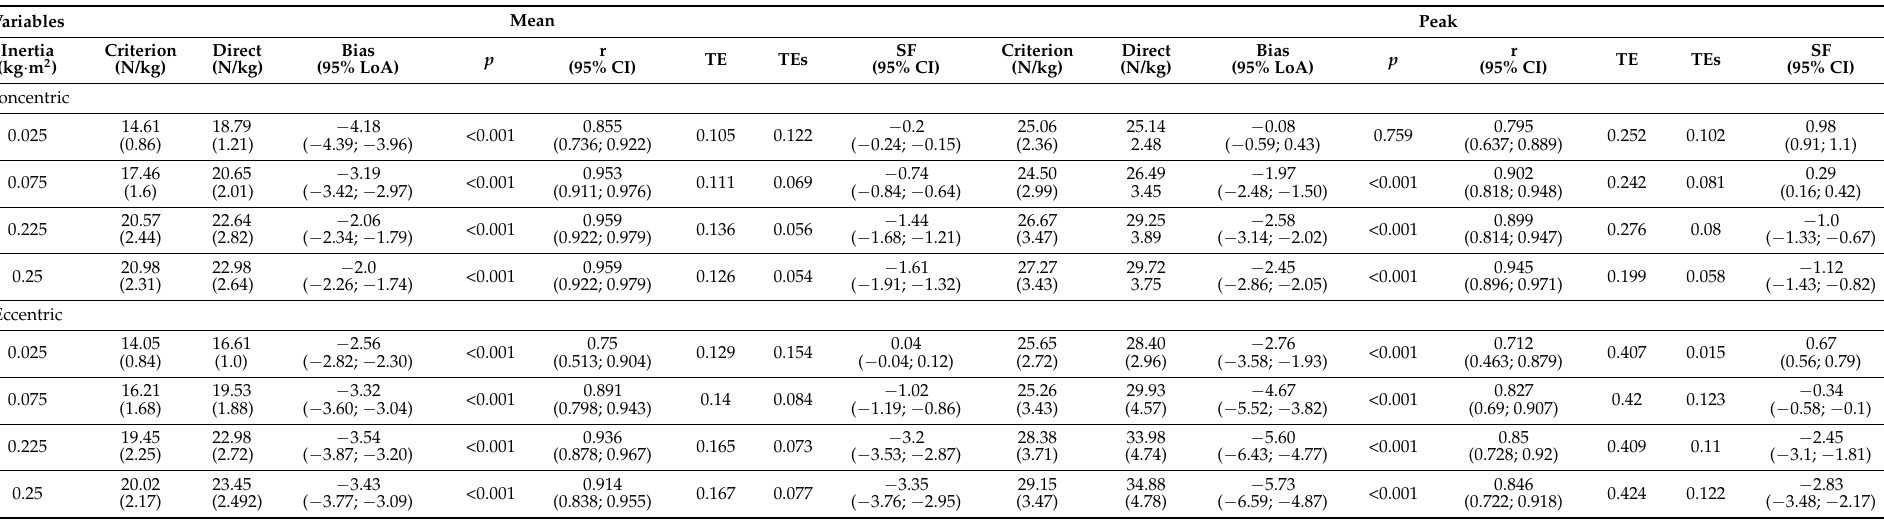
Table 4. Agreement of ground reaction force values between criterion (force plate) and direct measures (rotary